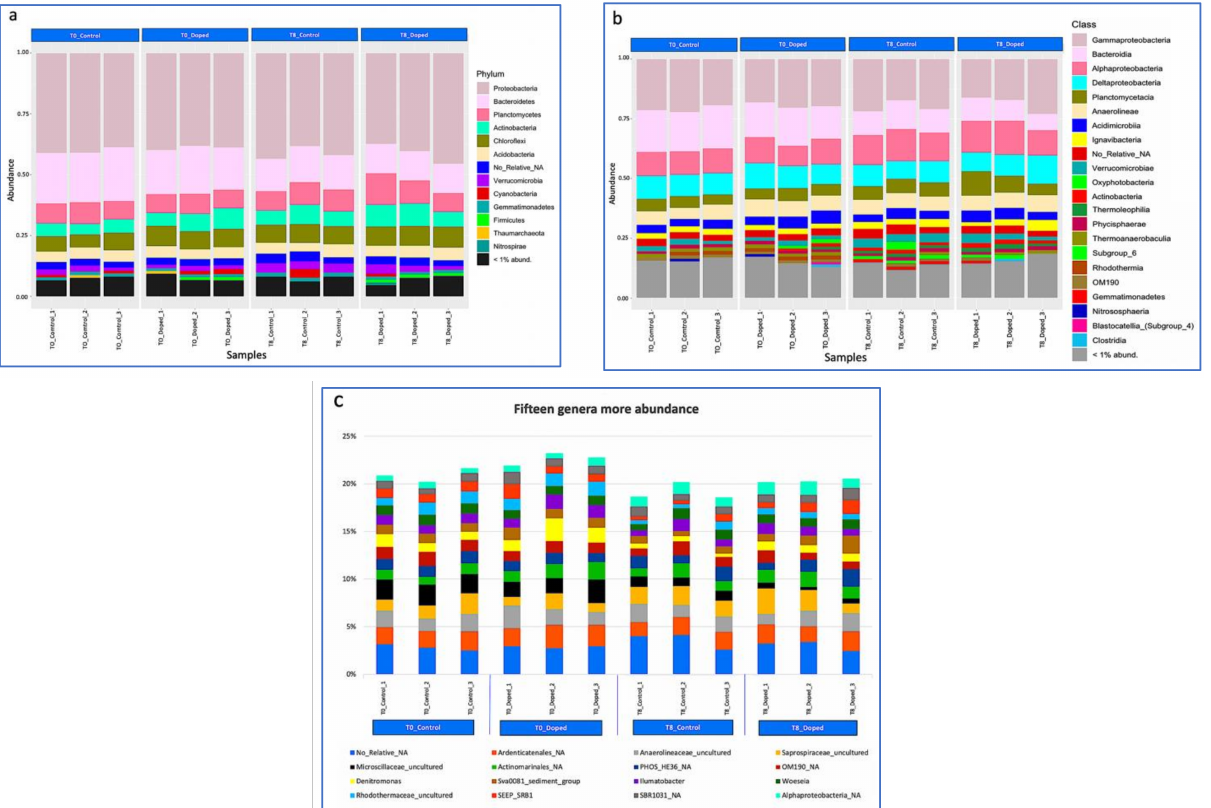
Figure 6. ( a ) Abundance of the major phyla, ( b ) classes with abundance > 1% and ( c ) genera more abundant of bacteria across the different CWs systems substrates, irrigated for eight weeks with Ribeira de Joane water not doped (control) or doped with NP and OP. Samples collected at the beginning (T0) and at the end of the experiment (T8) ( n = 3). <1% abund.: groups the phyla with abundance lower than 1%; “No_Relative_NA” groups the phyla without any close